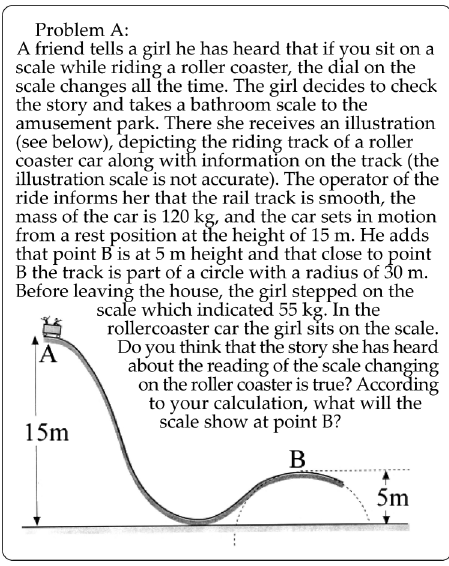
FIG. 2. The pre problem used in a self-diagnosis